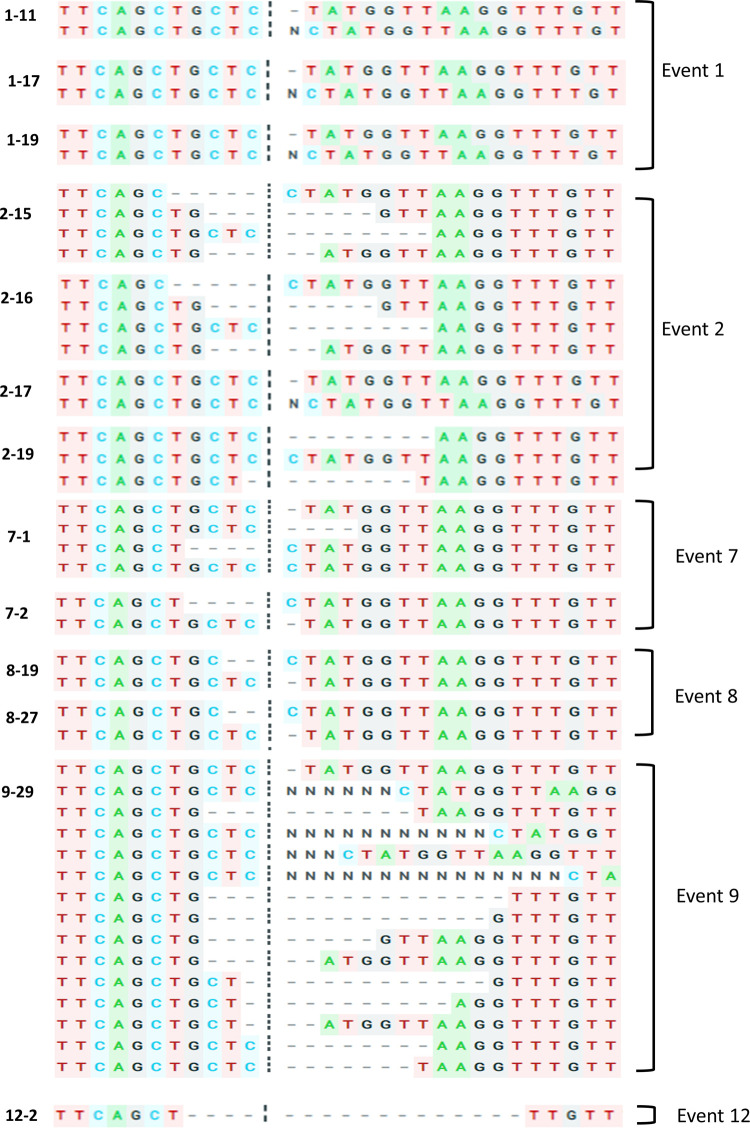
Sequence analysis of target region in the T0 mutant lines using ICE v2 CRISPR online tool.Vertical black dots represent the predicted cleavage site of Cas9 and the horizontal black hyphen denotes deletions.